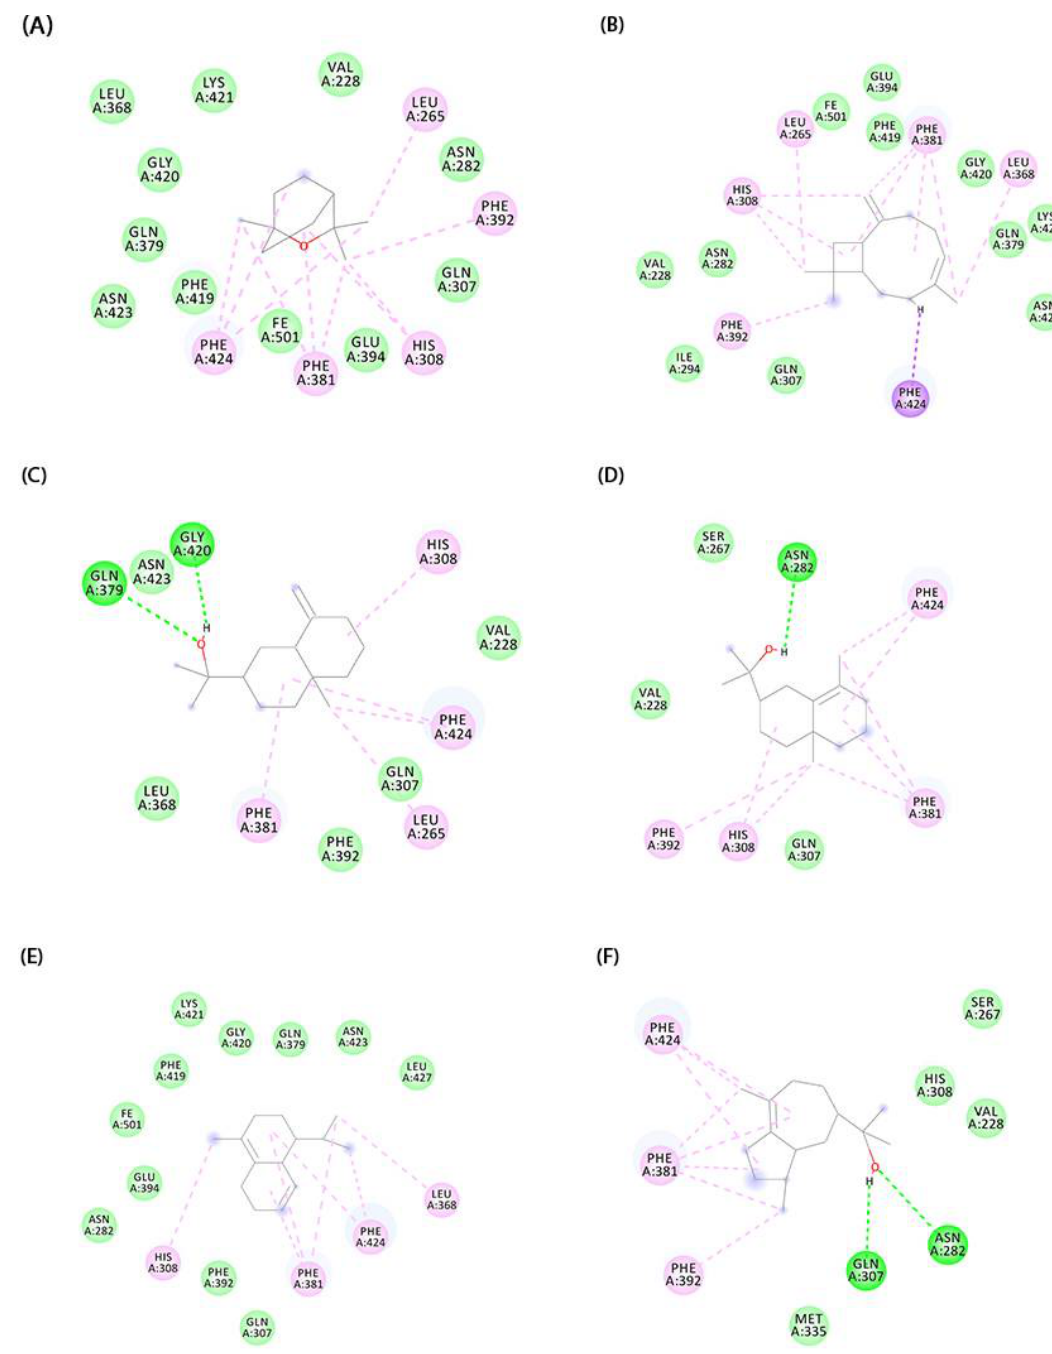
Figure 4. Docked conformation of molecules in the binding cavity of HPPD: In ( A ) we have the complex established with 1,8-Cineole, ( B ) (E)-Caryophyllene, ( C ) β-Eudesmol, ( D ) γ-Eudesmol, ( E ) δ-Cadinene, and ( F ) Bulnesol.